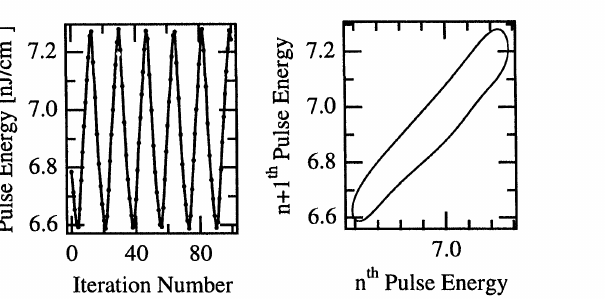
FIGURE 5 Time series and first return map for the unstable region of Fig. 4, demonstrating quasiperiodic